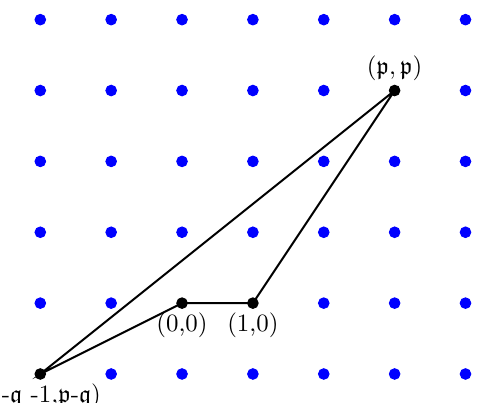
Figure 1 . Toric diagram for Y p ; q . Notice that this is not convex. The (cid:12)gure represents the choice p = 3, q = 4.